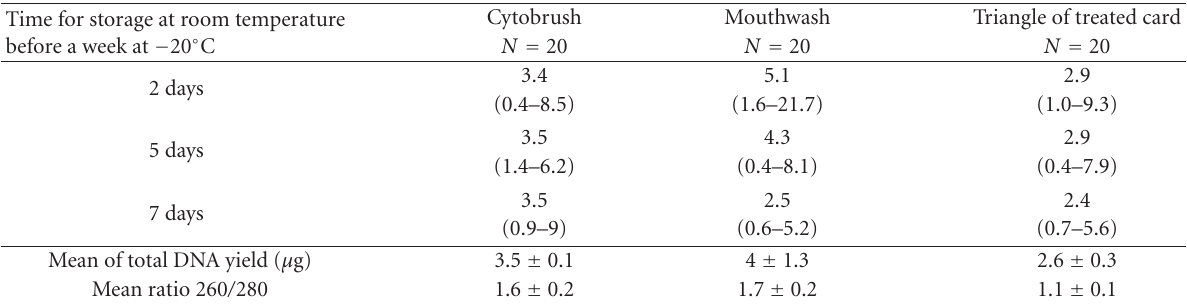
Table 1. Total DNA yield and range (in parentheses) in µ g three times, 20 subjects for the three di ff erent methods of buccal cell collection. The amount of DNA was measured on a spectrophotometer at 260 nm and at 280 nm to determine the ratio 260 / 280.